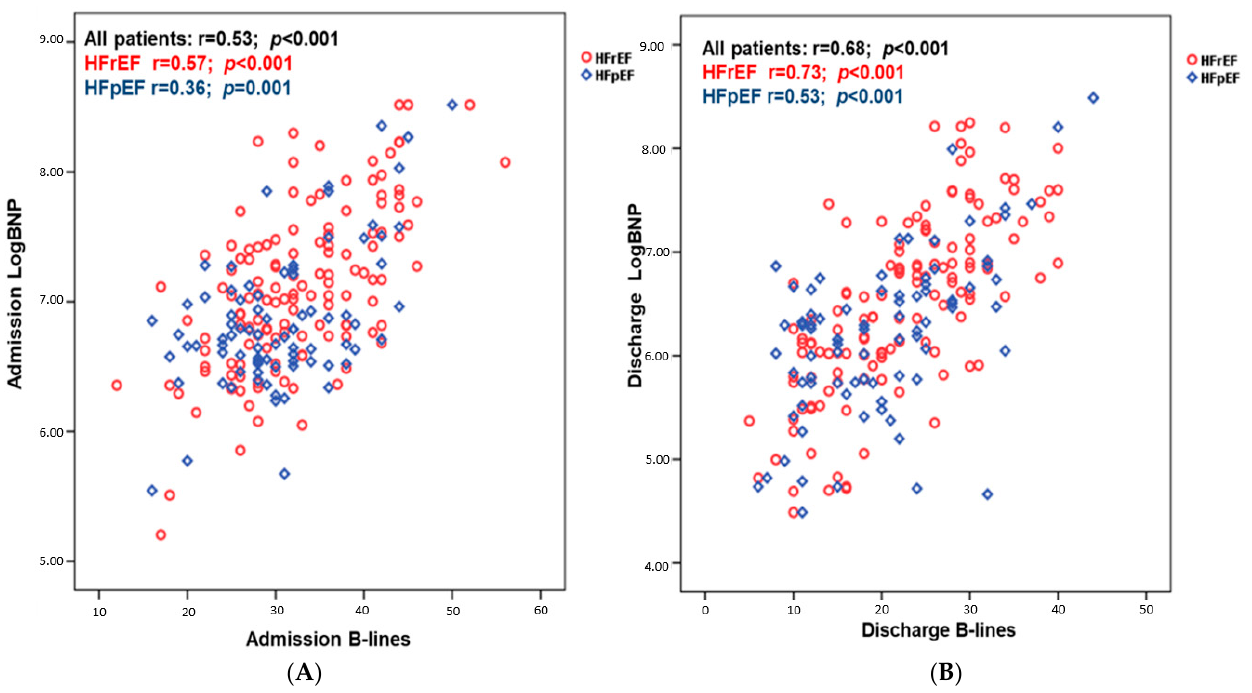
Figure 1. Correlation existing between LogBNP and B-lines number at admission ( A ) and at discharge ( B ) dividing patients according to ejection fraction.